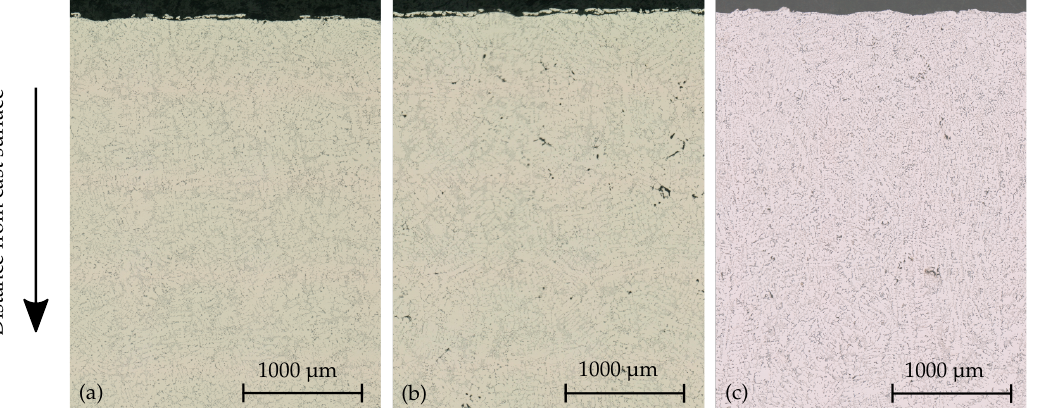
Figure 2. Microstructure of ( a ) HIP P1, ( b ) T6 P1 and ( c ) T6 P2. Table 2. Evaluated mean dendrite arm spacing (DAS) for T6 and HIP at P1 and P2. Measurement Position T6 P1 HIP P1 HIP P2 T6 P2 [49] HIP P2 [49] surface DAS [µm] 27.3 26.5